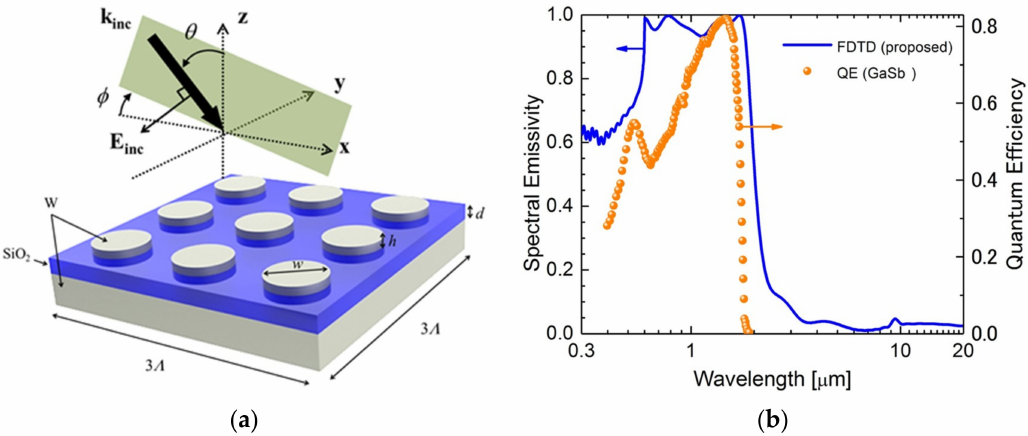
Figure 1. ( a ) Schematic of the proposed metasurface. ( b ) Simulated spectral emissivity of the proposed emitter obtained from finite-difference time-domain (FDTD) simulation (blue dot) and the quantum efficiencies (QE) of the GaSb PV cell (orange dot)